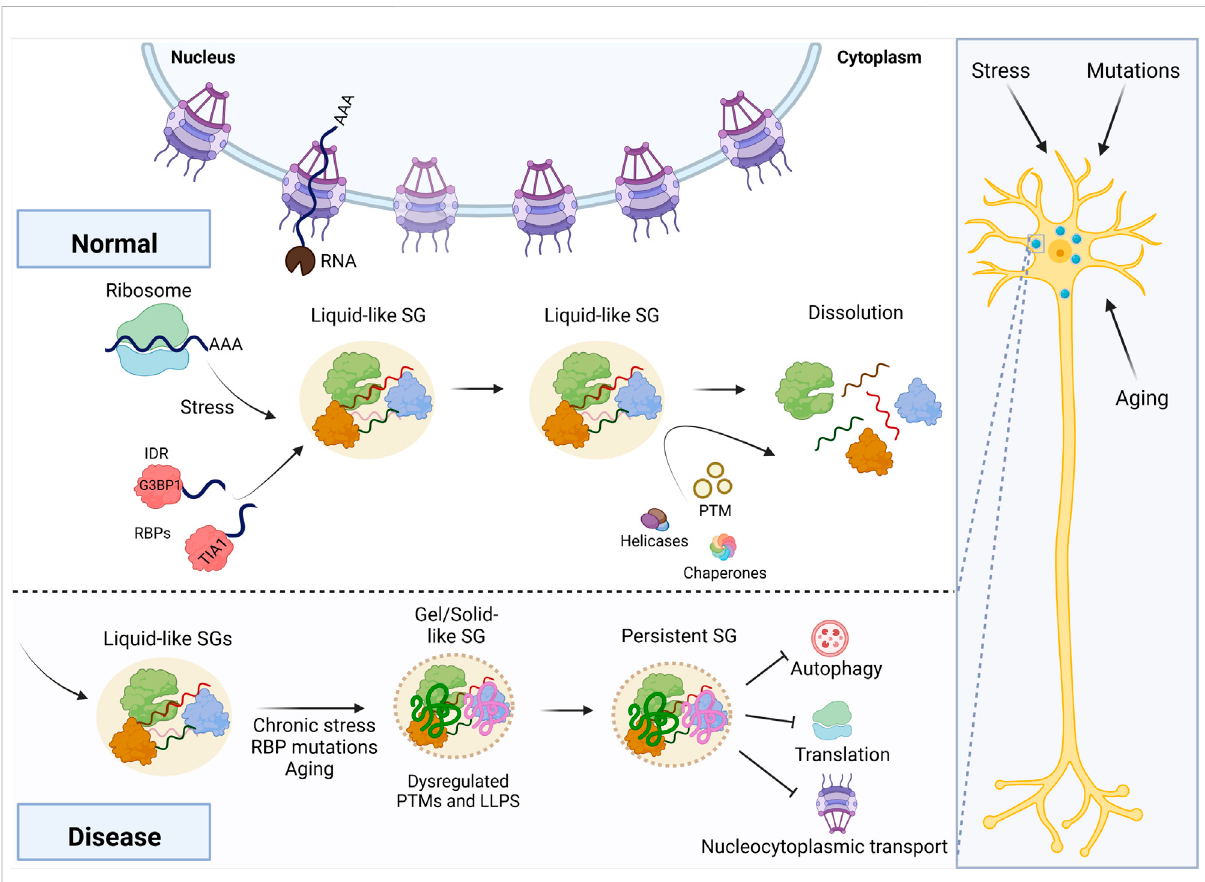
FIGURE 1 MaturationofRNAgranulesintodisease-associatedstates.Stress,aging,andmutationscanallstallneuronaltranslation,initiatingstressgranule assembly via G3BP1. Chronic stress exposure or other mechanisms may lead to a disease-associated outcome, in which the granule transitions to a gel- or solid-like state. In turn, this persistent granule disrupts cellular homeostasis, including autophagy, translation, and nucleocytoplasmic transport. This fi gure was created using